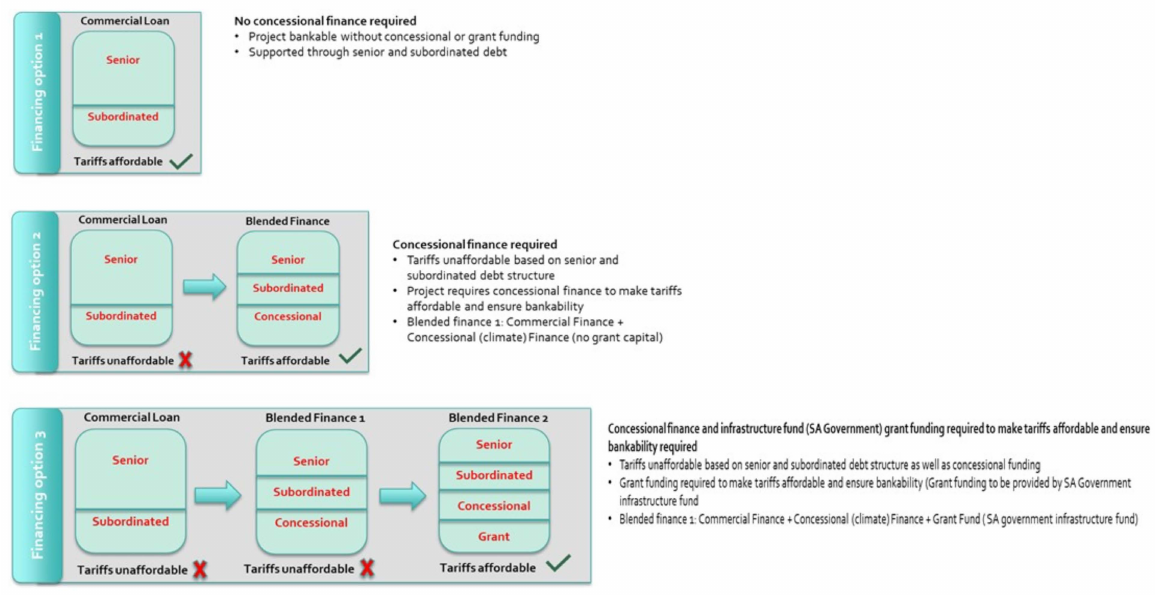
Figure 1. Financing options and